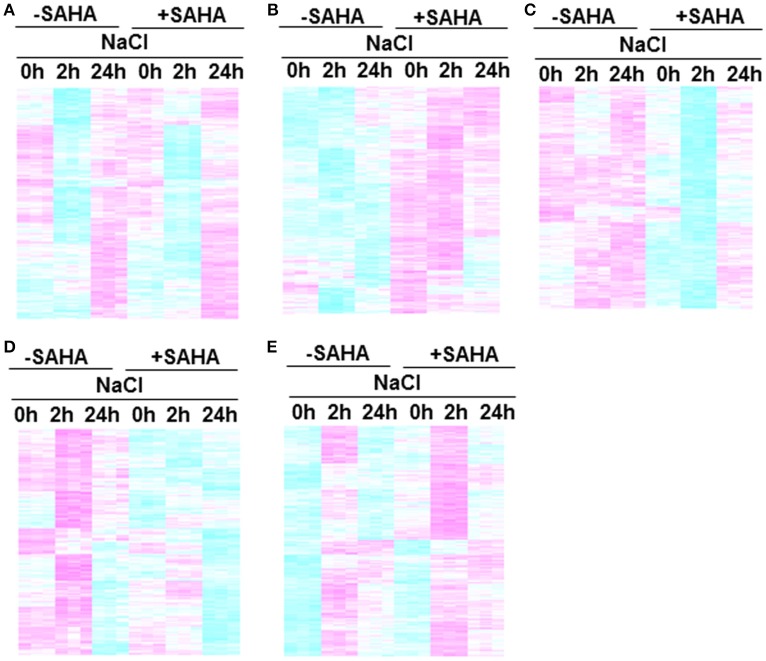
Clustering of genes in root transcriptome. Each cluster includes genes that responded to treatment conditions: (A) Class 1, SAHA-unaffected genes; (B) Class 2, genes up-regulated by SAHA treatment; (C) Class 3, enriched salt-stress unresponsive genes down-regulated at 2 h after NaCl addition in SAHA-pretreated plants (D) Class 4, enriched salt-stress responsive genes down-regulated at 2 h after NaCl addition in SAHA-pretreated plants, (E) Class 5, salt-responsive genes up-regulated at 2 h after NaCl addition in SAHA-pretreated plants.